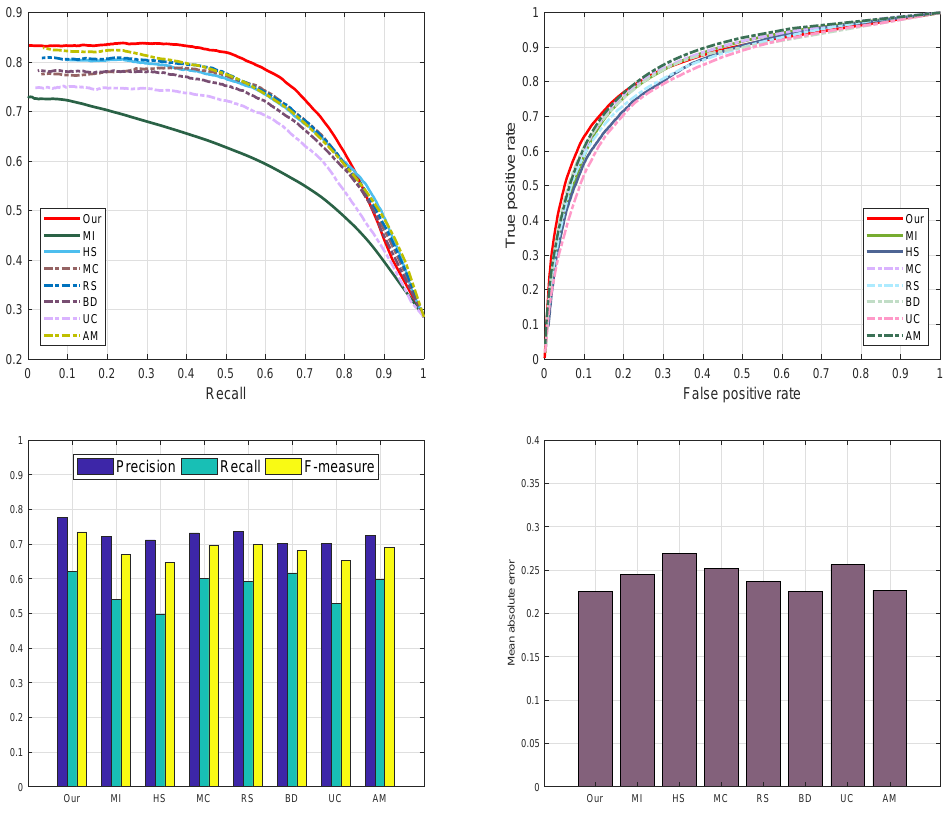
Figure 12. Graphical evaluation of our model using the PR-curve, F-measure, ROC-curve, and MAE with seven most recent